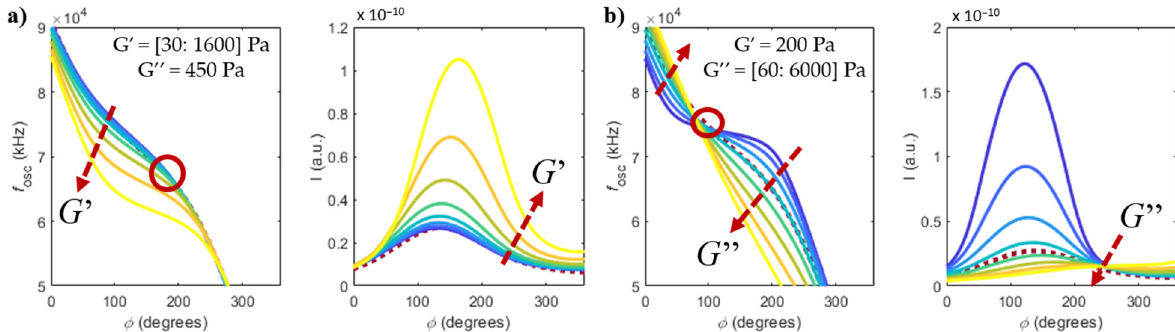
Figure 3. Frequencies of oscillation and quadrature component of deflection I , as a function of the imposed phase in the PLL and the ( a ) elastic modulus and ( b ) viscous modulus of a viscoelastic fluid. The dashed burgundy line represents the case of purely viscous water. Only the branch with n = 2 is shown.